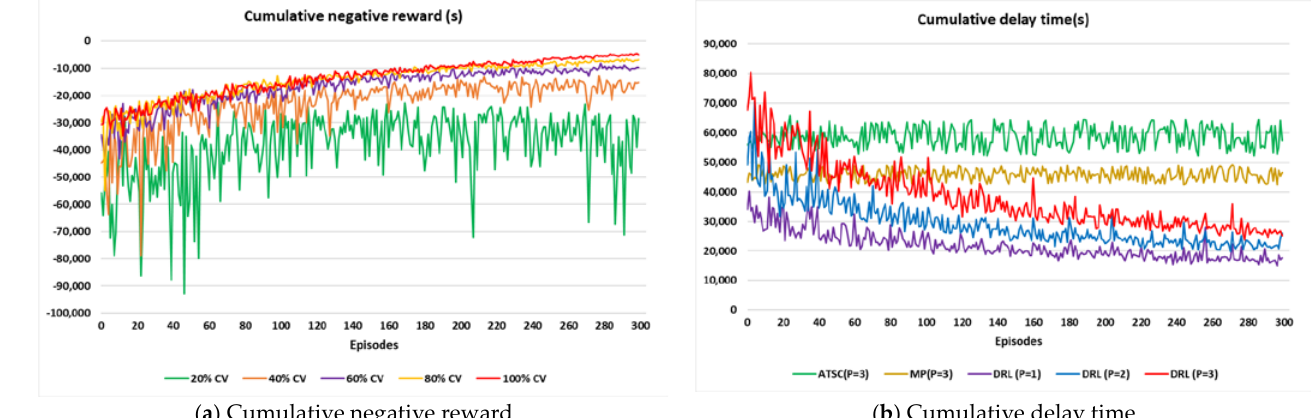
Figure 14. Cumulative negative reward and delay time with different CV penetration rates.